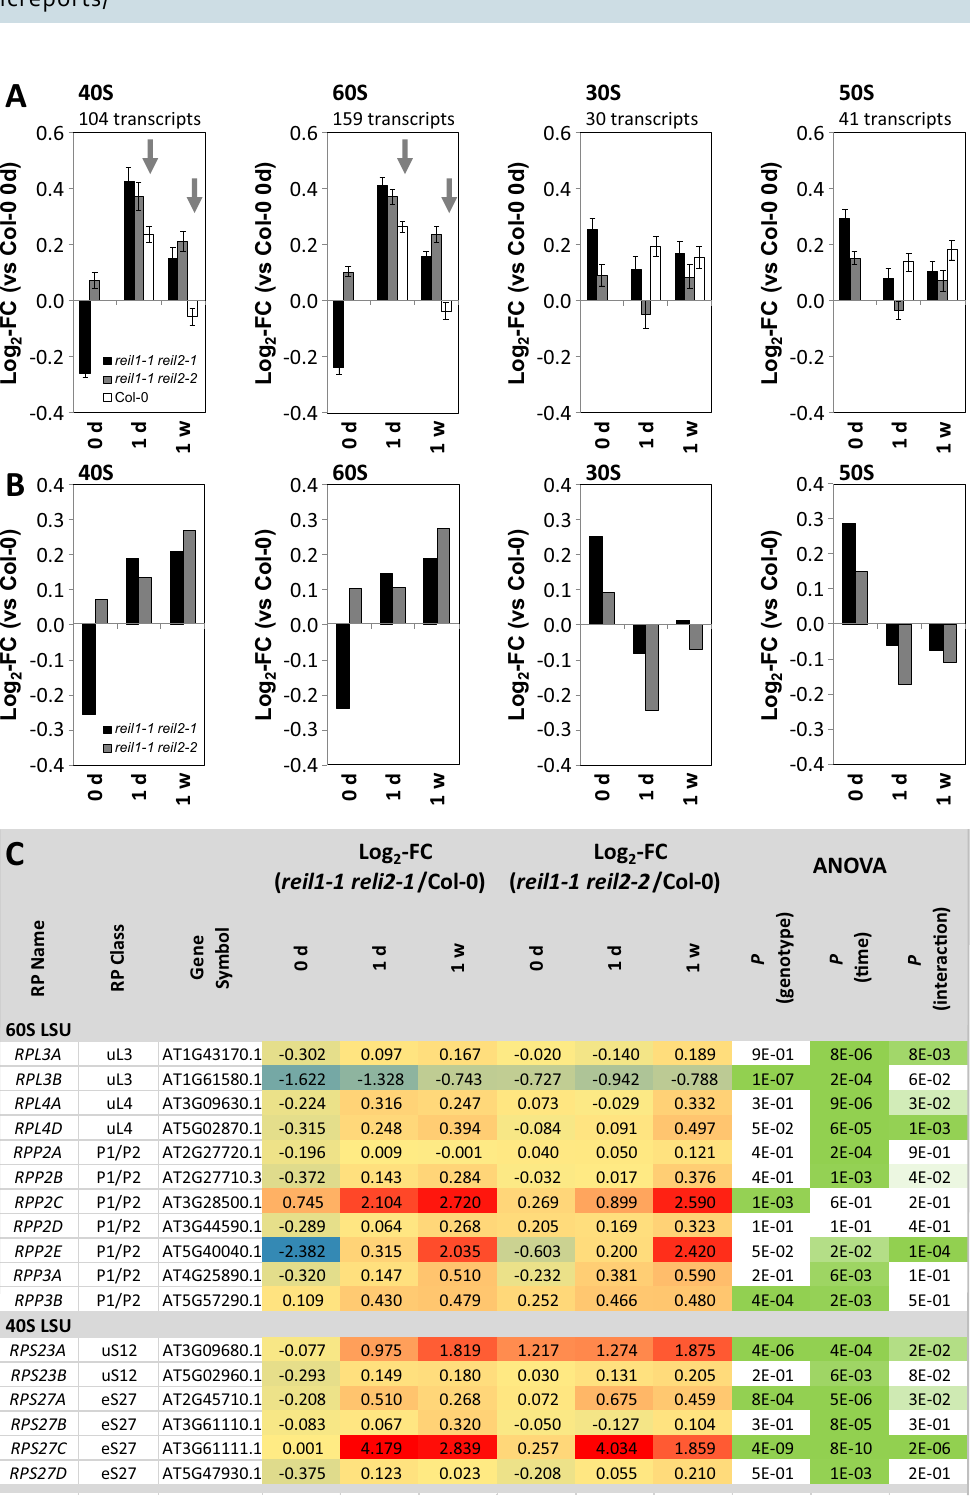
Figure 7. Differential expression of cytosolic and plastid ribosomal genes in reil1-1 reil2-1 and reil1-1 reil2-2 double mutant roots in the non-acclimated state (0 day, 20 °C) and shifted to 10 °C cold for 1 day or 7 days. ( A ) Average log 2 -fold change (FC, means + / − standard error) relative to non-acclimated Col-0 (0 day) of transcripts coding for ribosome proteins (RPs) from the cytosolic 40S and 60S subunits and from the plastid 30S and 50S subunits. Grey arrows indicate transcript accumulation of the mutants in the cold. ( B ) Average log 2 -fold changes relative to Col-0 at each time point calculated from the means of the data from (A). ( C ) Log 2 -fold changes relative to Col-0 at each time point of selected cytosolic RP families. Two-factorial analysis of variance (ANOVA) indicates differential effects of the genotype, cold exposure (time) or the interaction of both on the expression of paralogous RPs from the 60S and the 40S subunits in the mutants. The three-color scale of the log 2 -FC heat map ranges from − 3.0 (blue) to 0.0 (yellow) to ≥ + 3.0 (red). The two-color significance scale ranges from P ≤ 1.0 × 10 –10 (1E-10, dark green) to P < 0.05 (5E-2, light green), P ≥ 0.05